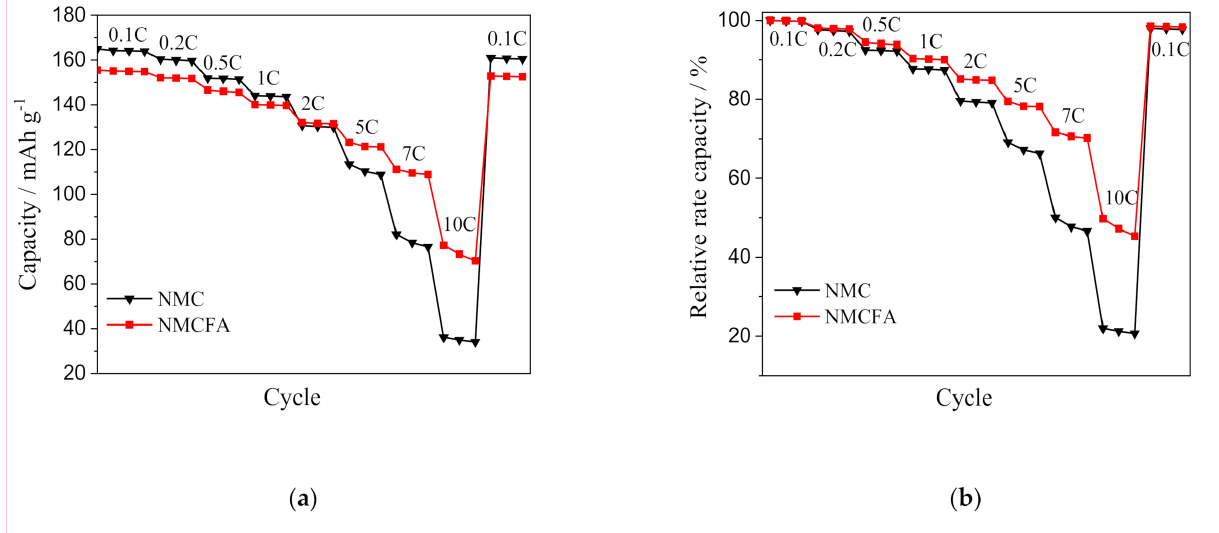
Figure 5. ( a ) Rate performance and ( b ) the corresponding relative rate capability of NMC and NMCFA at various